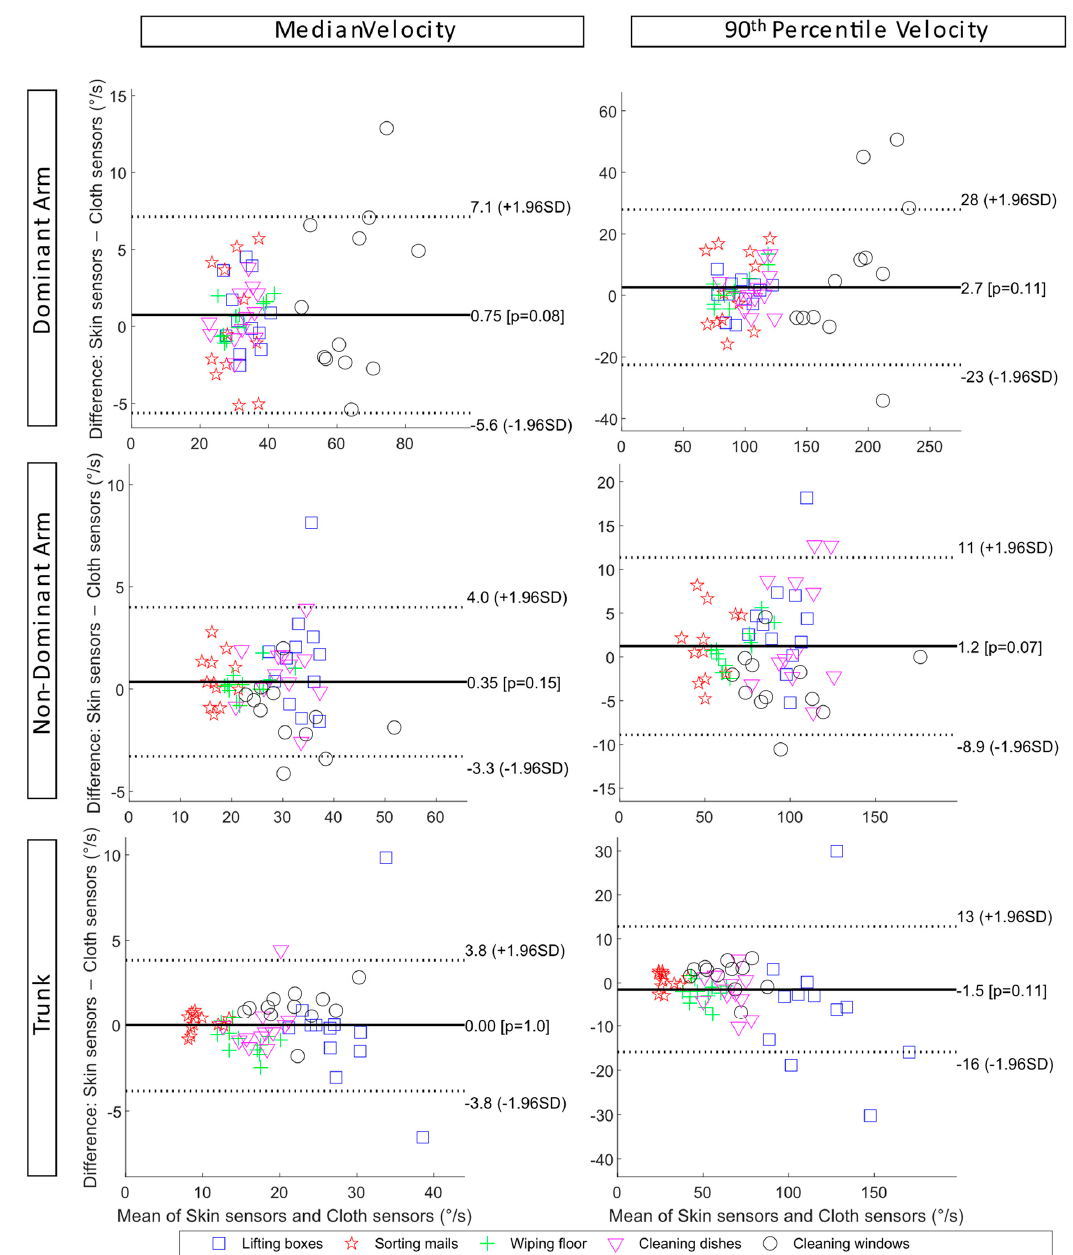
Figure 7. Bland–Altman plots of the upper arm inclination velocity and trunk forward inclination velocity during the five simulated work tasks show the limits of agreements between skin sensors and cloth sensors. From top to bottom: the dominant arm, the non-dominant arm, and the trunk. To the left is the median inclination velocity, and to the right is the 90th percentile inclination velocity.